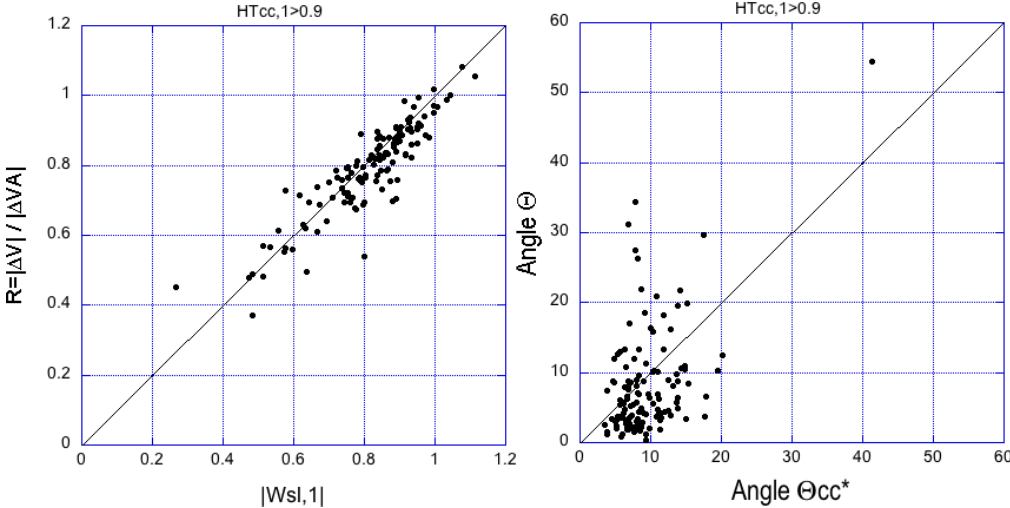
Fig. 10. Scatterplot of the R = | 1 v | / | 1 V A | ratios and the angles, 2 , between 1 v and 1 V A , obtained from Wal´en tests in the spacecraft frame, versus the corresponding quantities from the tests in the HT frame, (the slope W slope , 1 and the angle 2 ∗ cc ), obtained from the 1min Wal´en scatterplots, for the cases with HT cc , 1 ≥ 0.9.